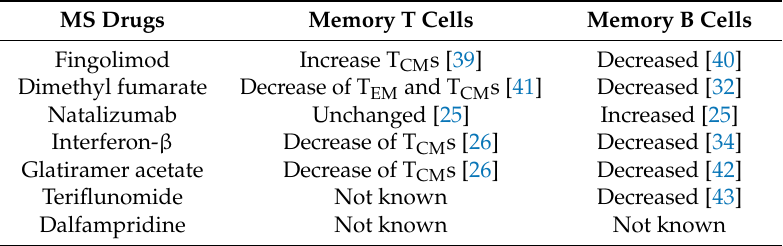
Table 1. The effect of multiple sclerosis (MS) drugs on different kinds of memory